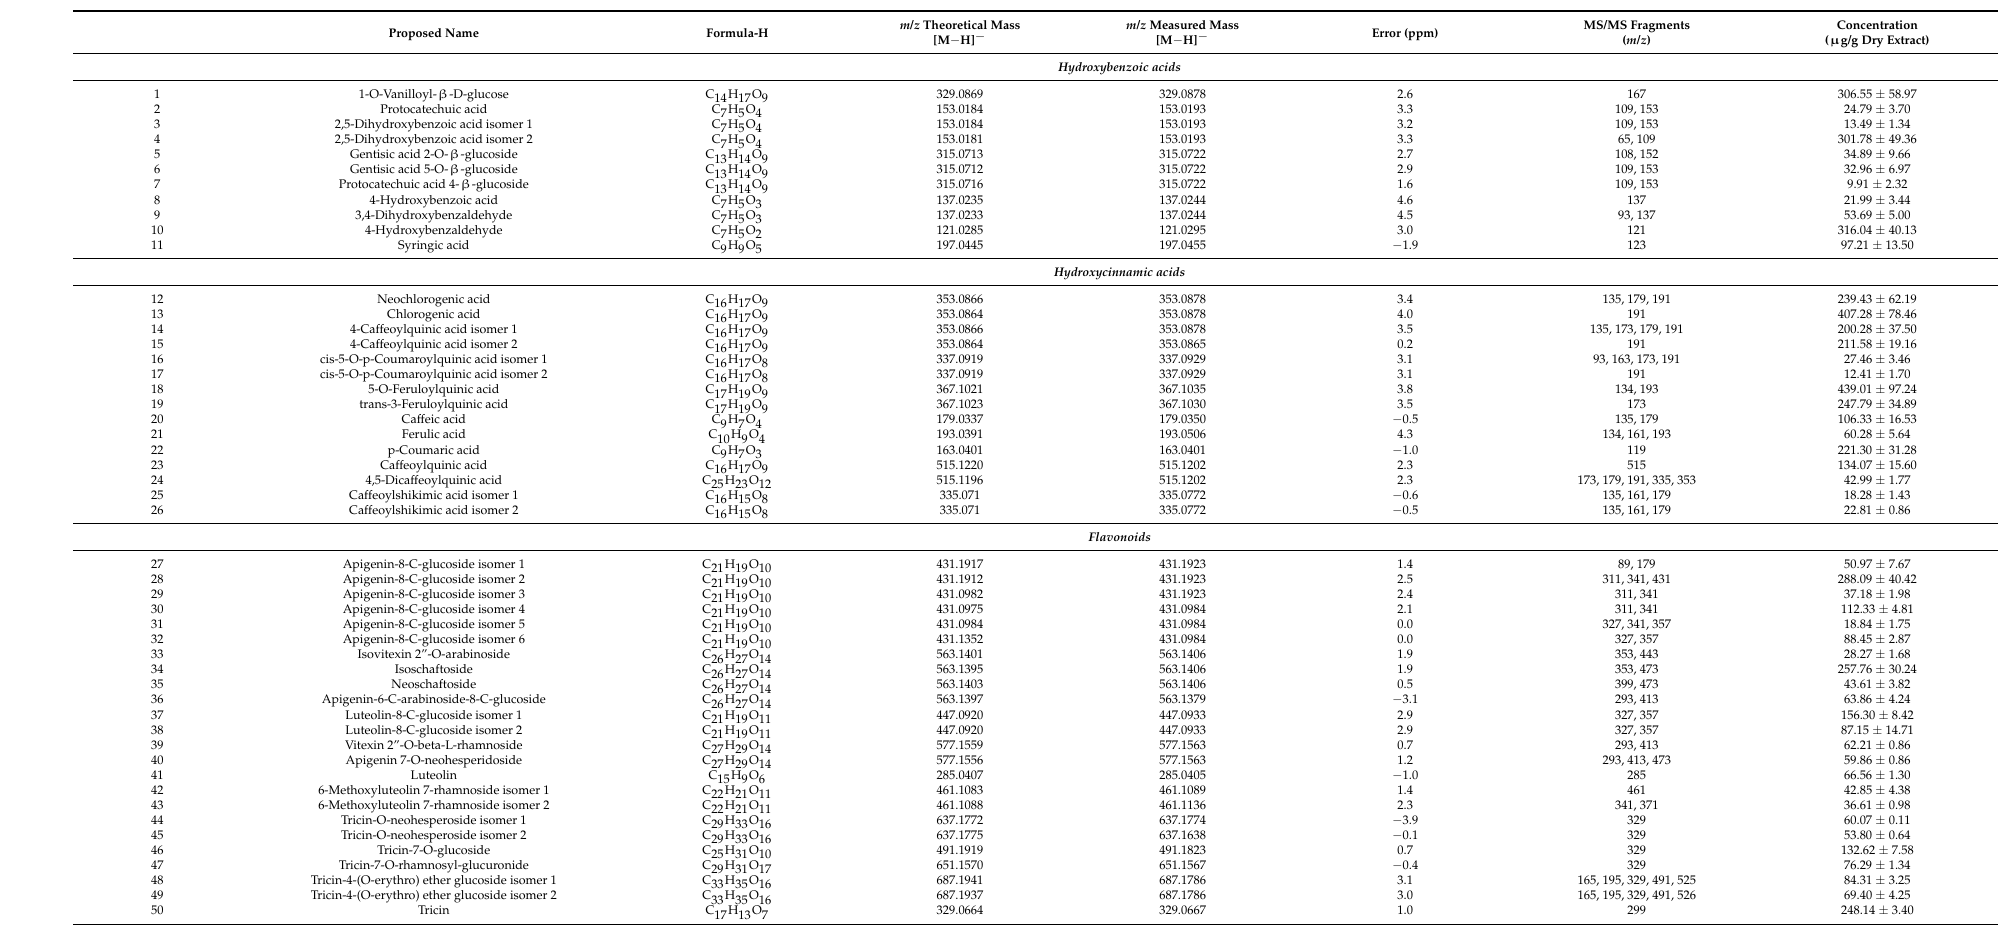
Table 1. LC-ESI-UHR-QqTOF-MS data of phenolic compounds identified and quantified (means ± SD, µ g/g dry sugarcane straw